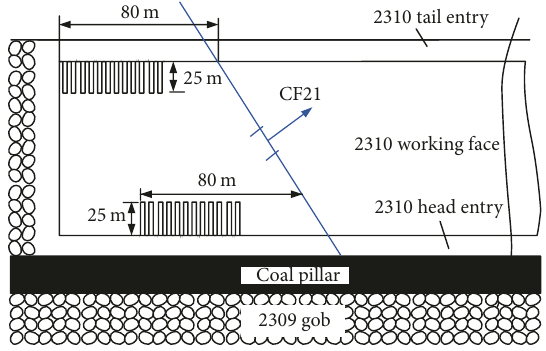
Figure 9: Arrangement of destressing boreholes on working face.